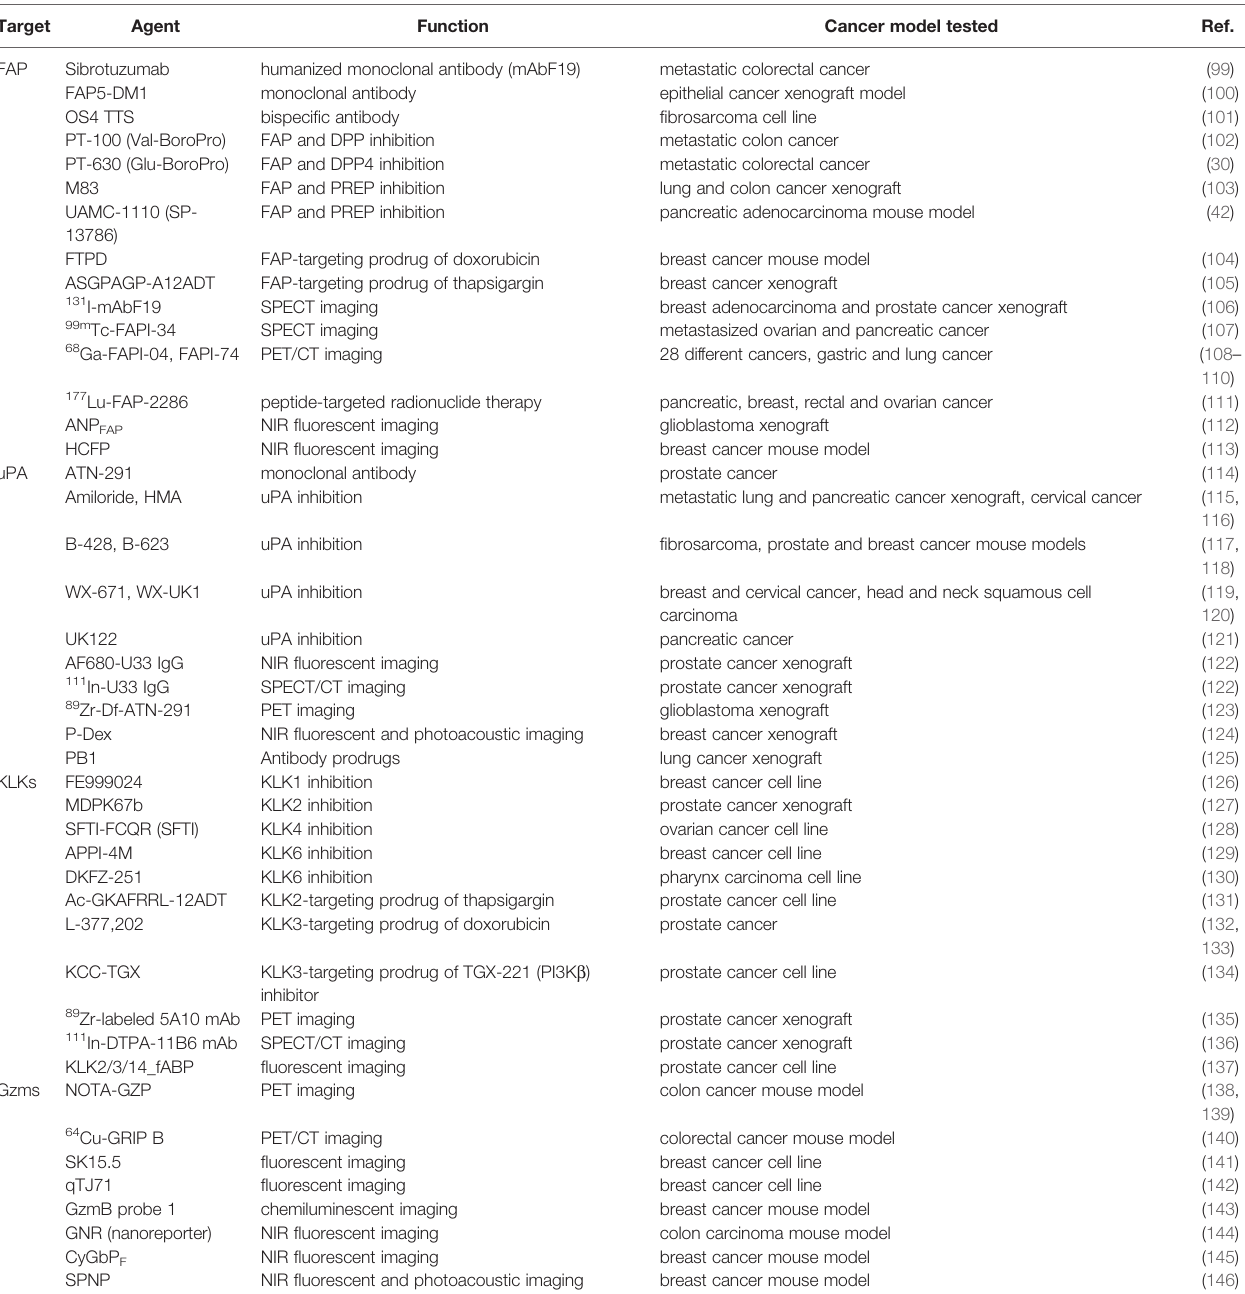
TABLE 1 | Theranostic targeting of serine proteases. Target Agent Function